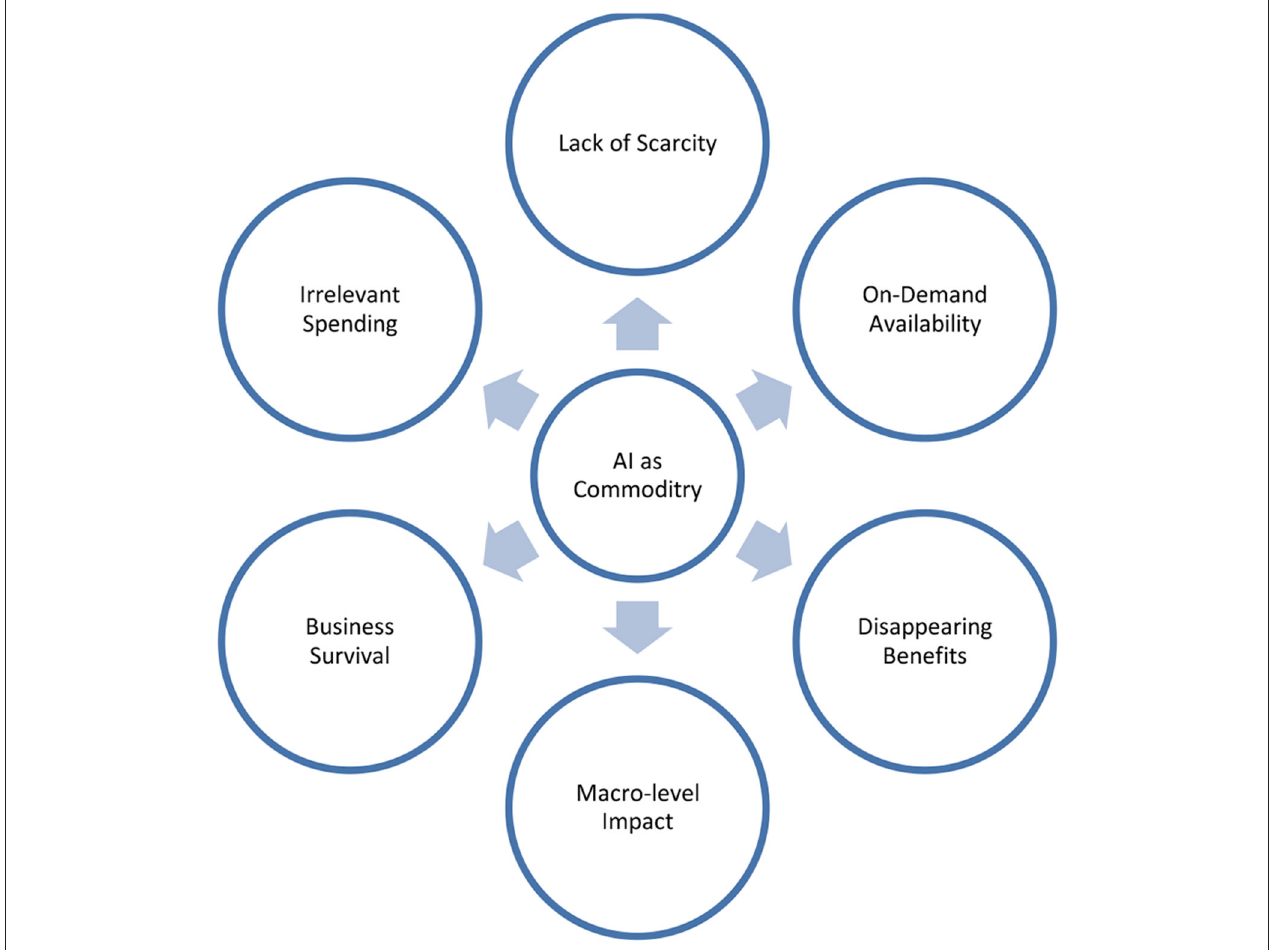
FIGURE 1 | AI commodity